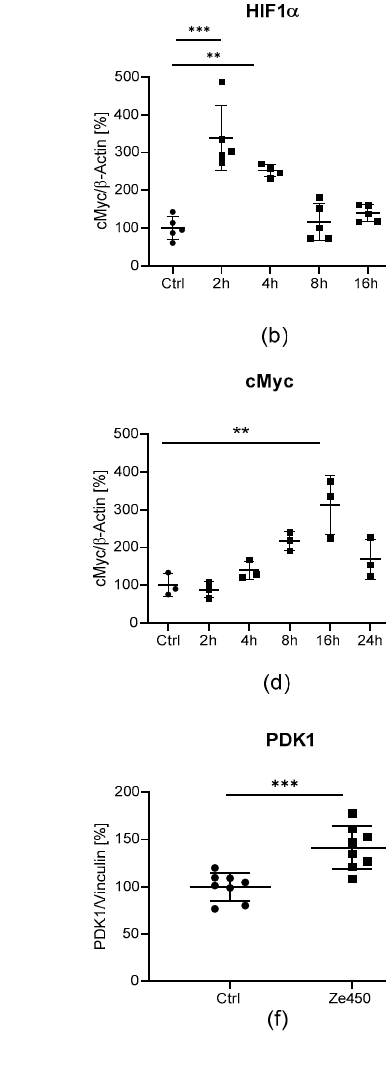
Figure 3. Effects of Ze 450 on protein levels of metabolic key regulators. ( a ) Effects of 100 µg/mL Ze 450 on HIF1 α protein levels were investigated via Western Blot after 2–16 h treatment in HT22 cells. ( b ) Quantification of Western Blot after 2– 16 h of treatment with 100 µg/mL Ze 450 depicted as optical density compared to β -Actin as loading control ( n = 5/treat- ment condition; *** p < 0.001; ** p < 0.01; unpaired t -test). ( c ) Representative Western Blot showed the effect of 100 µg/mL Ze 450 treatment on cMyc protein level after 2–16 h treatment in HT22 cells. ( d ) Quantification of Western Blot as optical density compared to β -Actin as loading control ( n = 3/treatment condition; ** p < 0.01; unpaired t -test). ( e ) Representative Western Blot of PDK1, and HXKII protein levels after 16 h of Ze 450 treatment (100 µg/mL) in HT22 cells. ( f , g ) Quantifi- cation of Western Blot as optical density compared to vinculin as loading control ( n = 8/treatment condition, *** p < 0.001; ** p < 0.01, unpaired t -test).